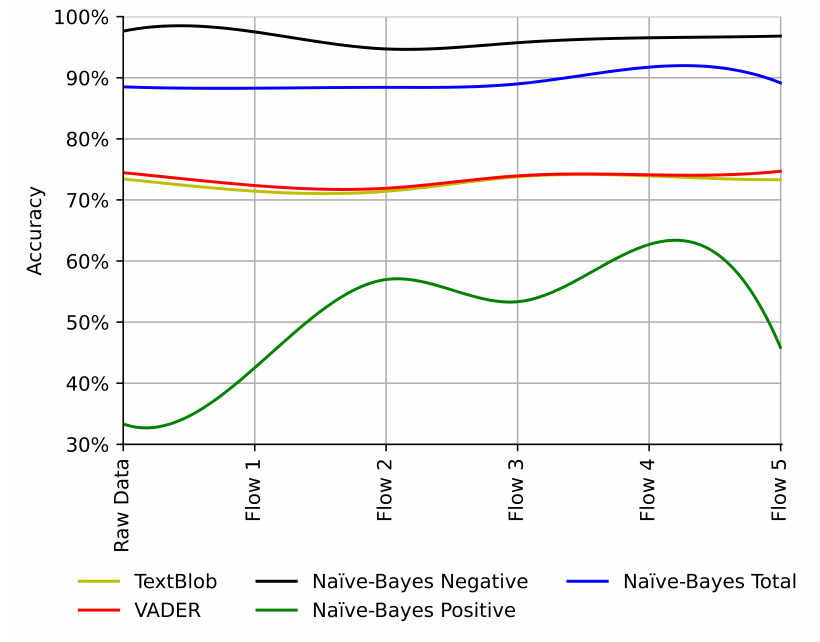
Figure 10. Accuracy of the classifiers on the gold